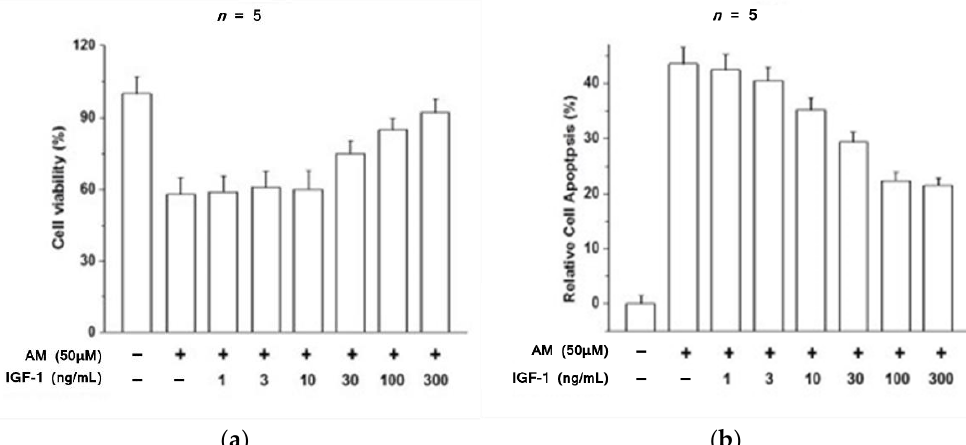
Figure 2. ( a ) The percentage of viable RPE cells decreases dramatically with the introduction of 50 μM AM, but this decline is attenuated by increasing the concentration of administered IGF-1 from 1 ng/mL to 300 ng/mL. ( b ) The percentage of apoptotic RPE cells significantly increases with the addition of 50 μM AM. The effect of AM on apoptosis is attenuated by addition of IGF-1 over a concentration range of 1 ng/mL to 300 ng/mL [37].